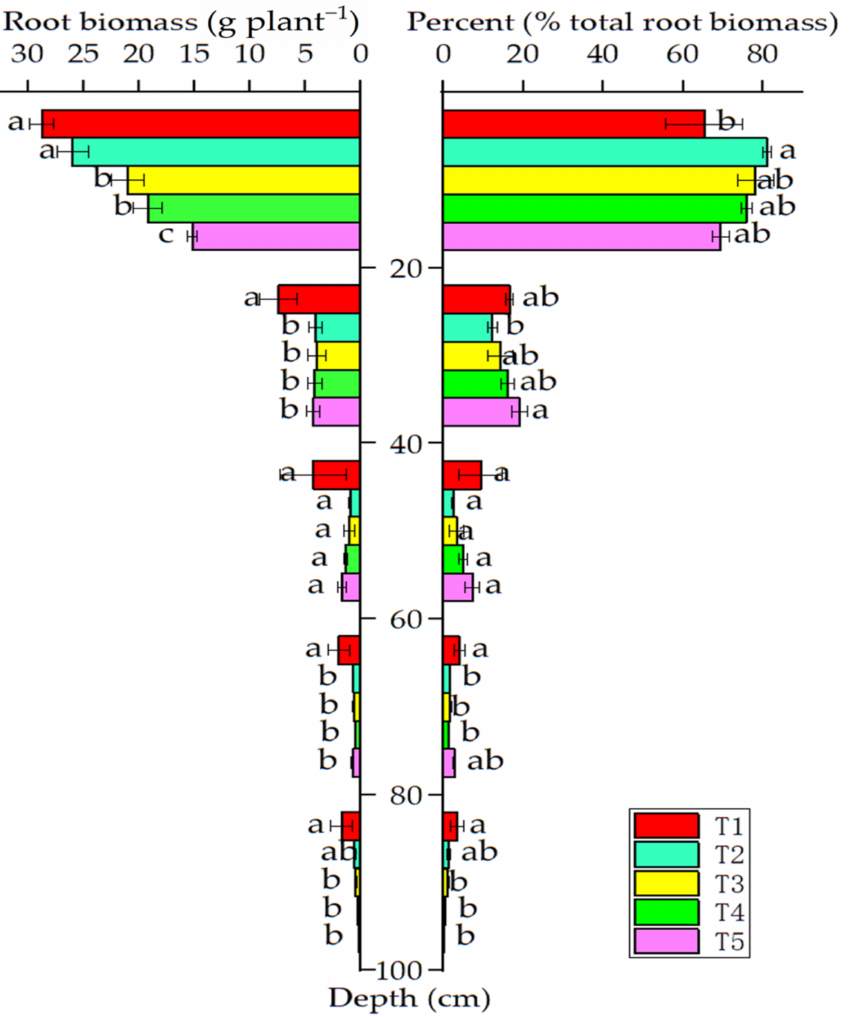
Figure 2. Root biomass and the proportion of biomass in the different soil layers across the 0–100 cm profile. The different letters within a depth layer denote significant differences ( p < 0.05) among the five population densities ( n =